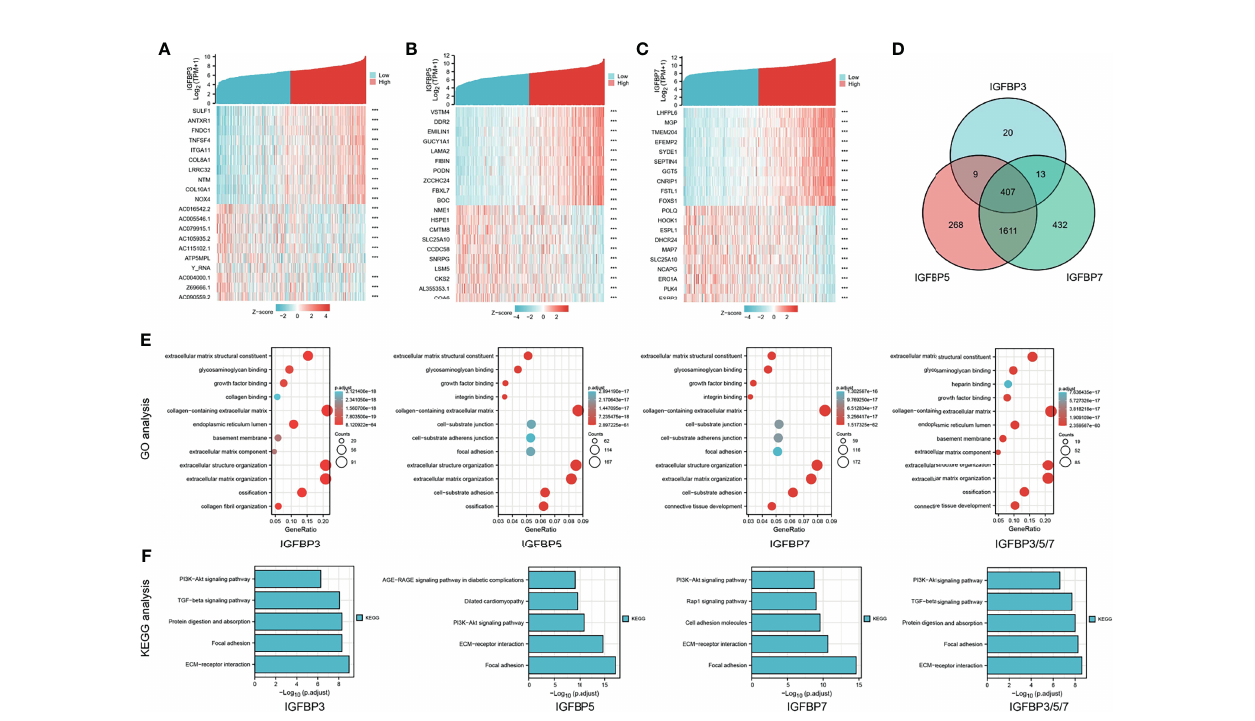
FIGURE 4 | Heat map, Venn diagram, and GO/KEGG analysis of IGFBP3/5/7. Heat map and Venn diagram showing top 10 genes with positive and negative co- expression with IGFBP3 (A) , IGFBP5 (B) , and IGFBP7 (C) in STAD patients from the TCGA database. (D) Intersection of genes co-expressed with IGFBP3/5/7. |r| > 0.4, p < 0.001. (E) GO analysis of IGFBP3, IGFBP5, IGFBP7, and IGFBP3/5/7 (407 overlap genes); (F) KEGG analysis of IGFBP3, IGFBP5, IGFBP7, and IGFBP3/5/ 7 (407 overlap